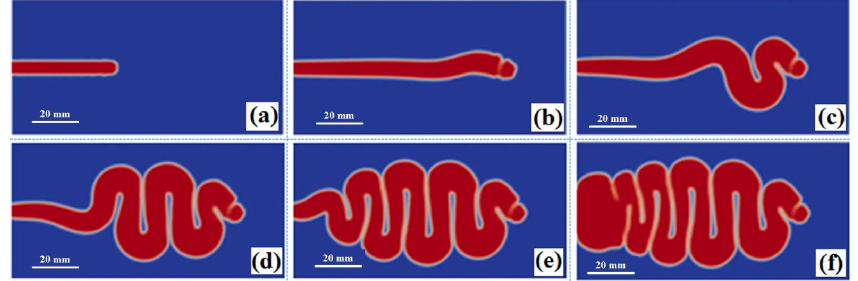
Figure 1. The simulated jetting evolution and buckling flows at ( a ) 0.2 s; ( b ) 0.4 s; ( c ) 0.6 s; ( d ) 1.0 s; ( e